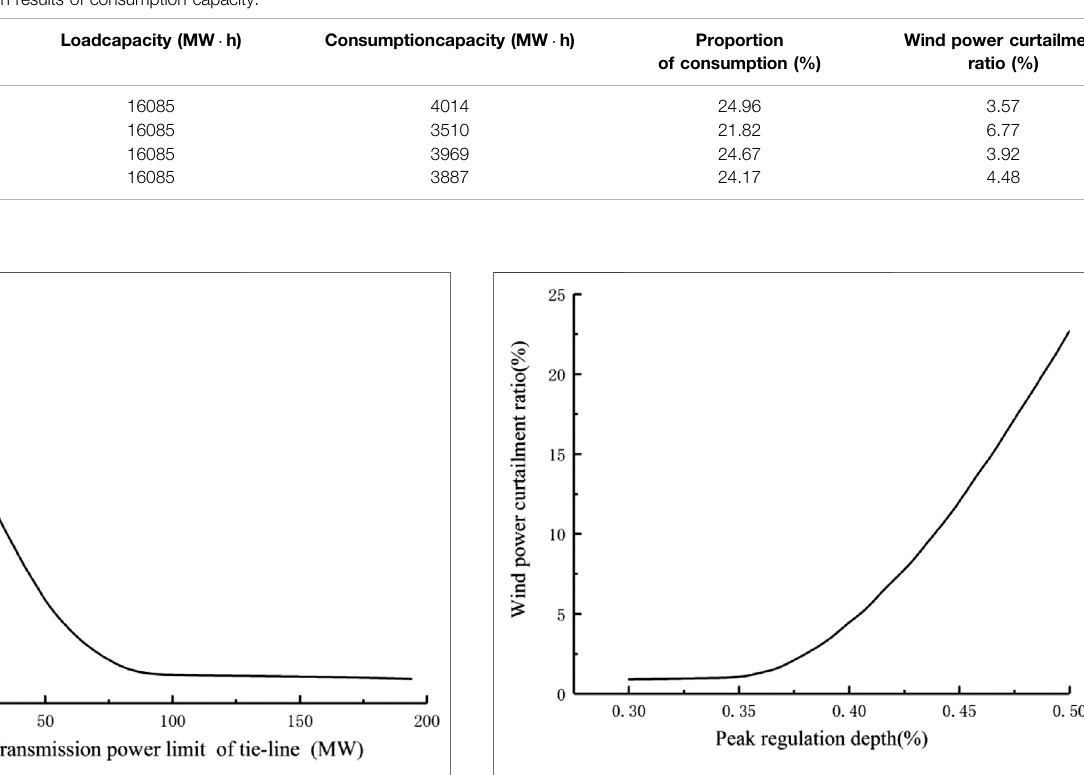
FIGURE 8 | Wind power curtailment ratio with different peak regulation